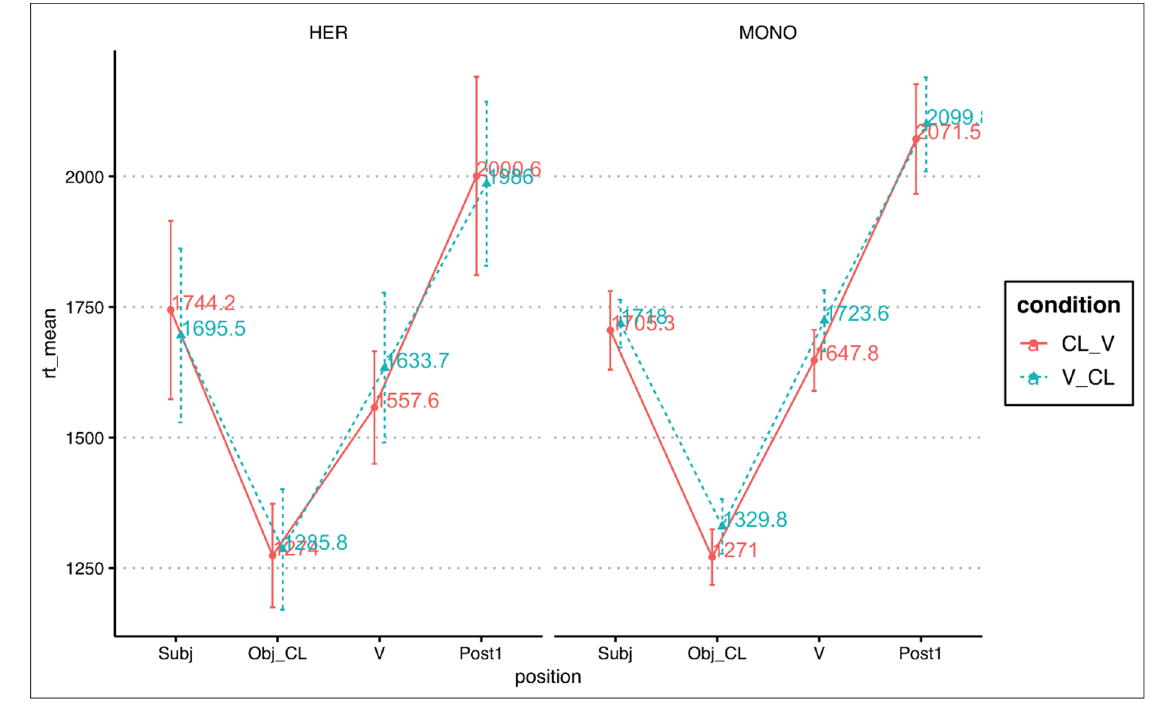
Languages 2022 , 7 , x FOR PEER REVIEW Figure 1. HS and baseline mean RTs of object clitics in Conditions 1 and 2. Figure 1. HS and baseline mean RTs of object clitics in Conditions 1 and 2.